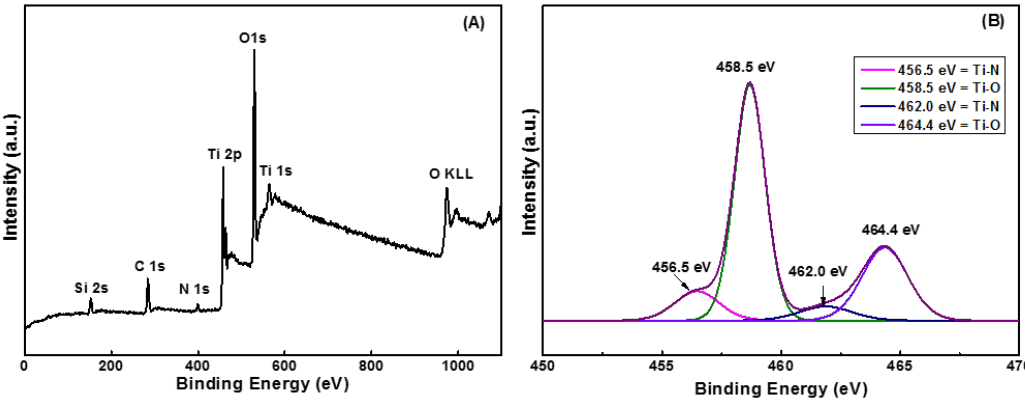
Figure 3. ( A ) Survey scan spectrum and ( B ) Ti2p spectrum of TiO 2 thin films deposited using Atmospheric Pressure Plasma Jet Jet with H 2 O vapor at fixed flow rate (500 mL/min) of Titanium ethoxide precursor and He = 5L/min + Ar = 300 mL/min.